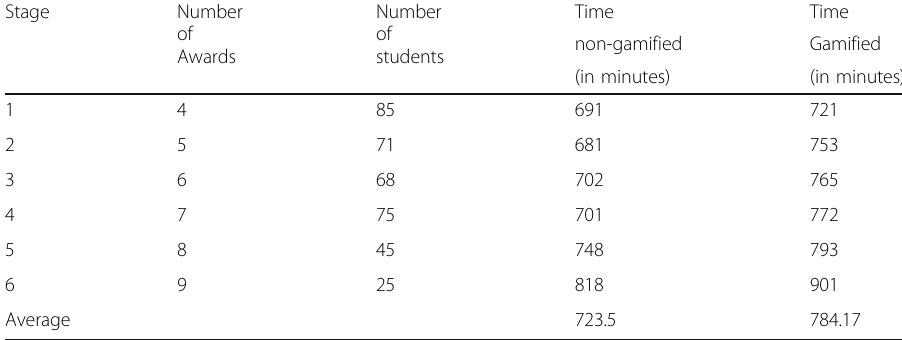
Table 2 Distribution of badges of included students Stage